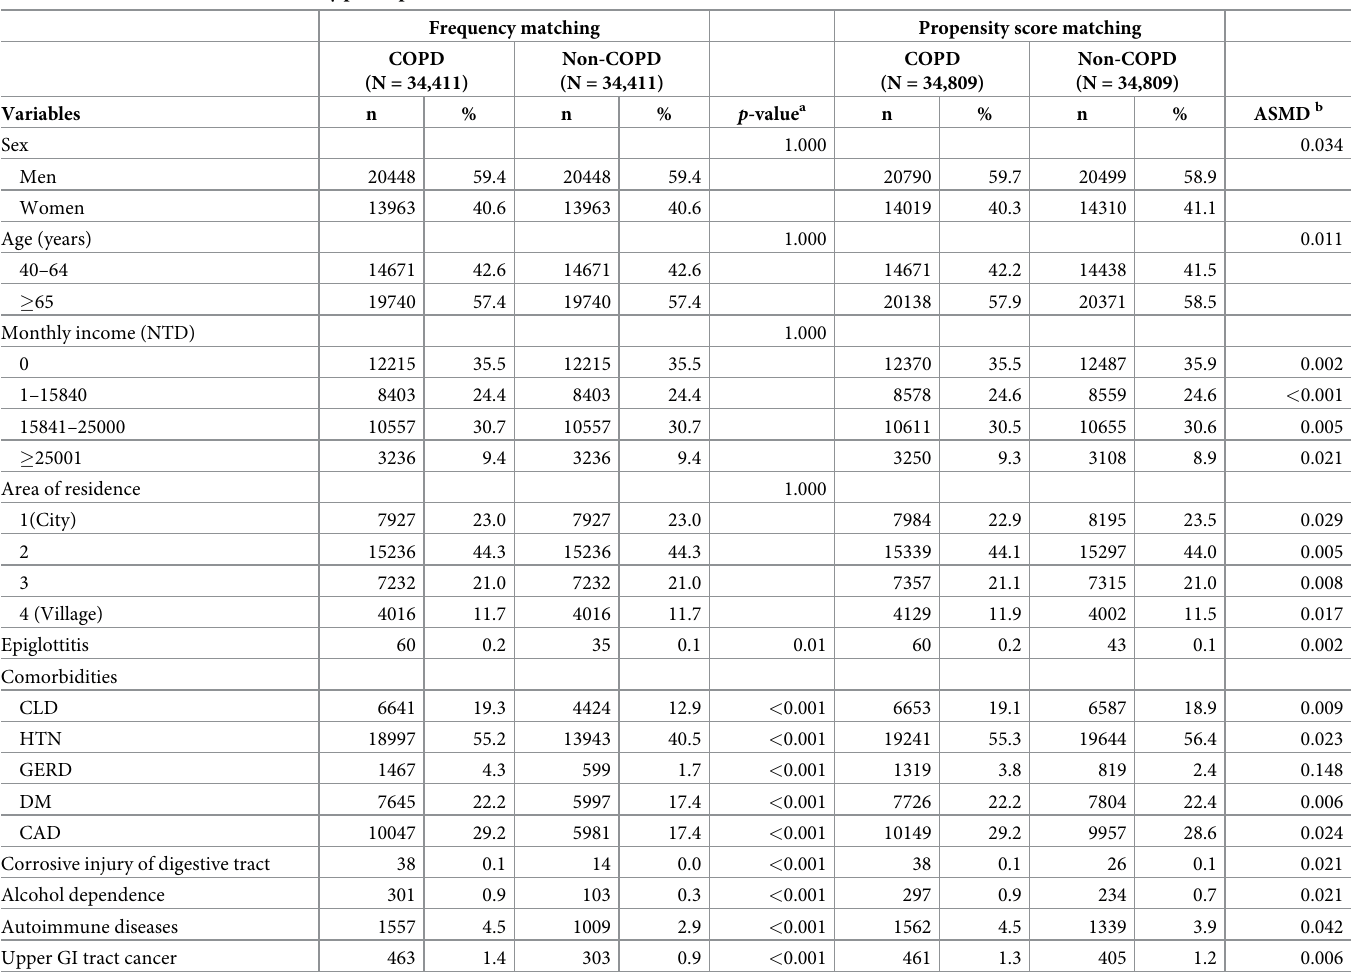
Table 1. Baseline characteristics of study